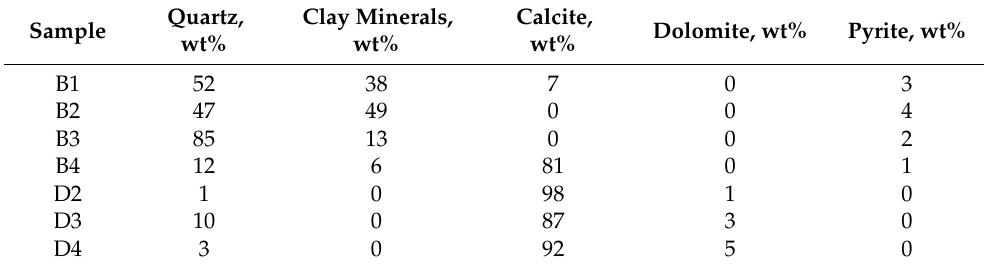
Table 4. X-ray Diffraction analysis results of the Domanik and Bazhenov samples.